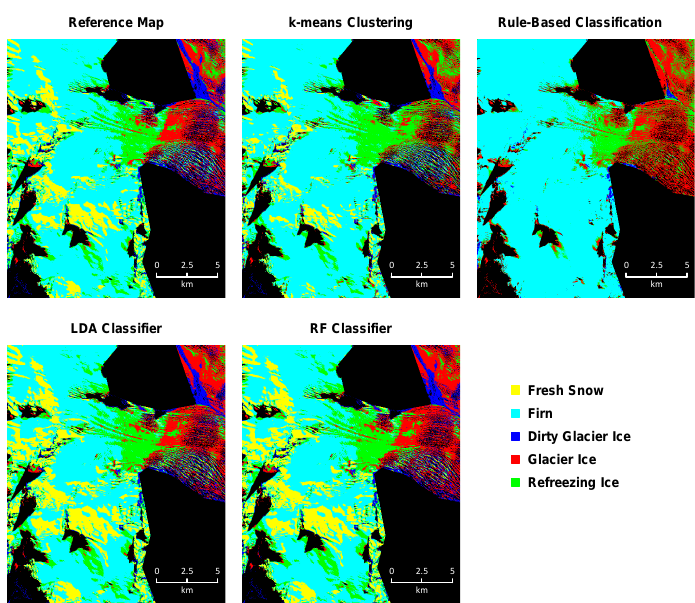
Figure 7. Reference and classification maps obtained from the four tested classification approaches: reference map obtained from the Nearest-Neighbor algorithm on labeled data; classification map obtained from k-means clustering ( k = 8) with a subsequent assignment of classes; classification map obtained from rule-based classification via snow and ice indices; classification map obtained from Linear Discriminant Analysis (LDA) classification; classification map obtained from Random Forest (RF)